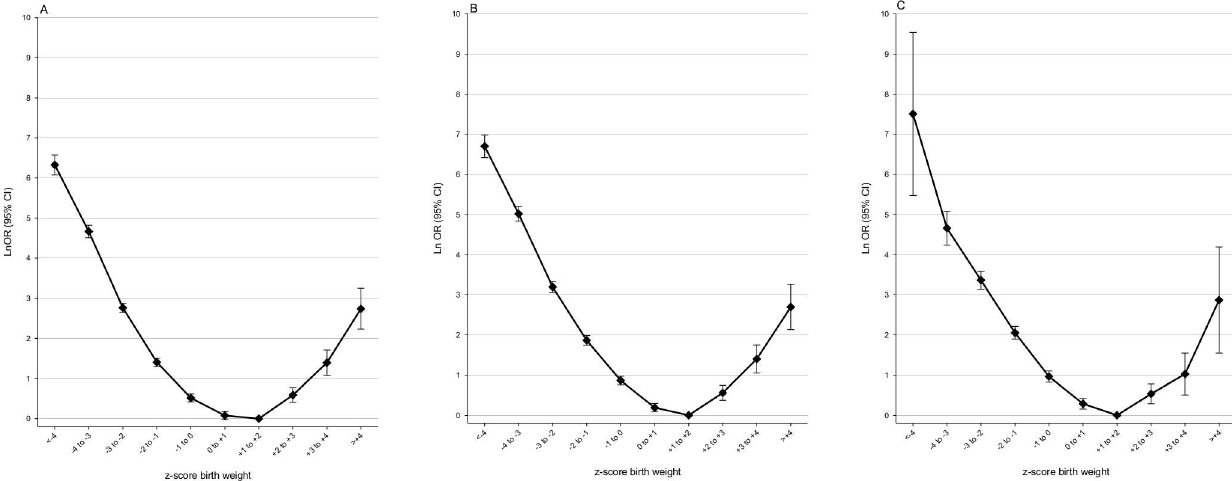
Fig 3. Associations between perinatal death and zBW in 3 different analytic models. CI: confidenceinterval; OR: odds ratio; zBW: z-score birth weight, standardized for year of birth, sex, birth order, gestational week, and plurality.(A) Model 1, crude (B) Model 2, includespotential family and individual level confounders (C) Model 4, fixed-effects model including23 546 participants in 7686 families, discordant with respect to perinataldeath. Model detailsprovidedin Table